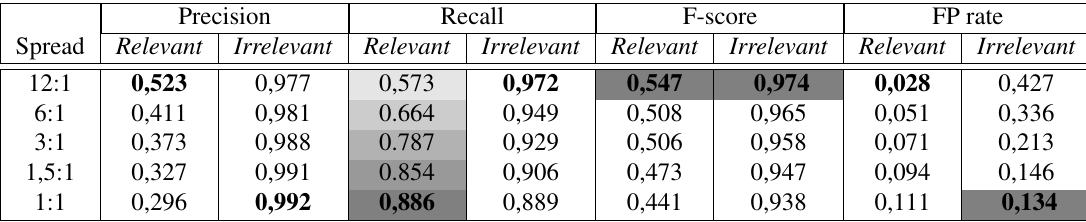
Table 6: Results of BN classifier for category A when applying different spread for random under-